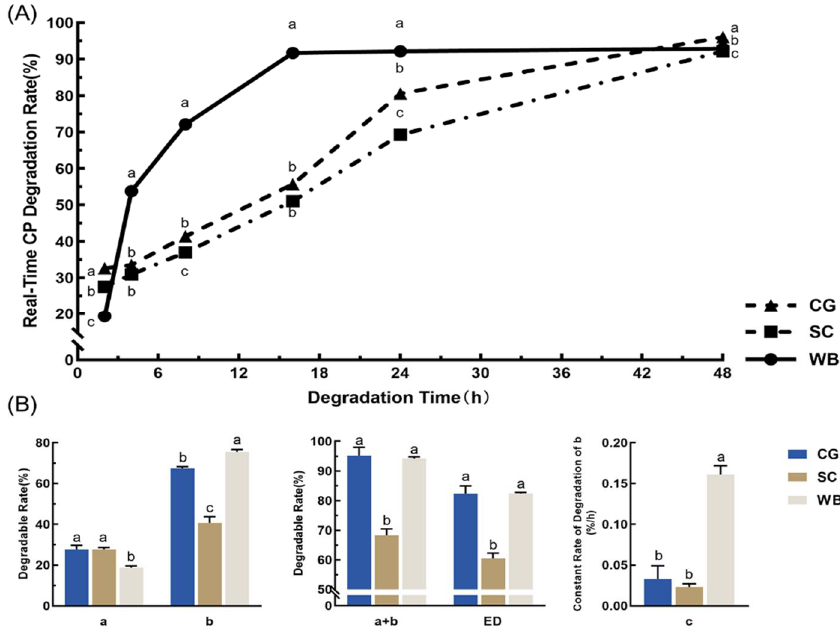
Figure 3. Rumen real-time degradability and degradation parameters of CP for three organic con- centrates (CG, SC, and WB). ( A ) Real-time degradation rates. ( B ) Degradation parameters. Data in the same parameter (in ( B )) or time points (in ( A )) of the superscript mark different lowercase letters indicate a significant difference ( p < 0.05). “a” (%): rapidly degradable fraction; “b” (%): the potentially degradable fraction; “c” (%/h): the constant rate of degradation of “b” (%/h); ED (%): effective degradability.